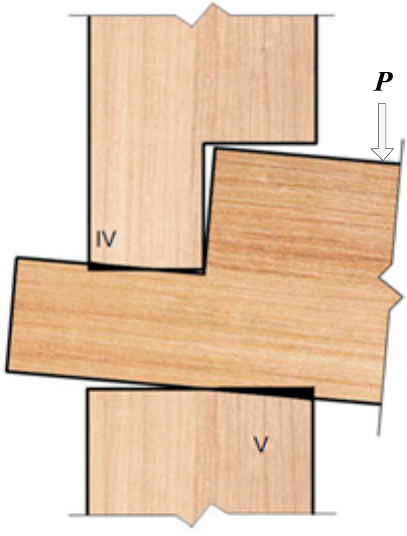
Figure 9. Positive rotation of tenon.